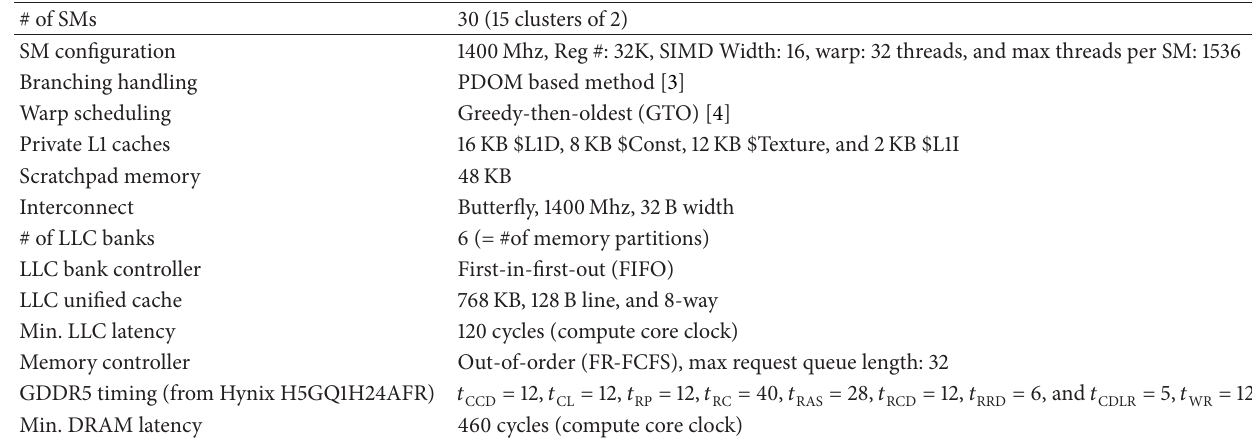
Table 1: Other configurations of baseline GPU.